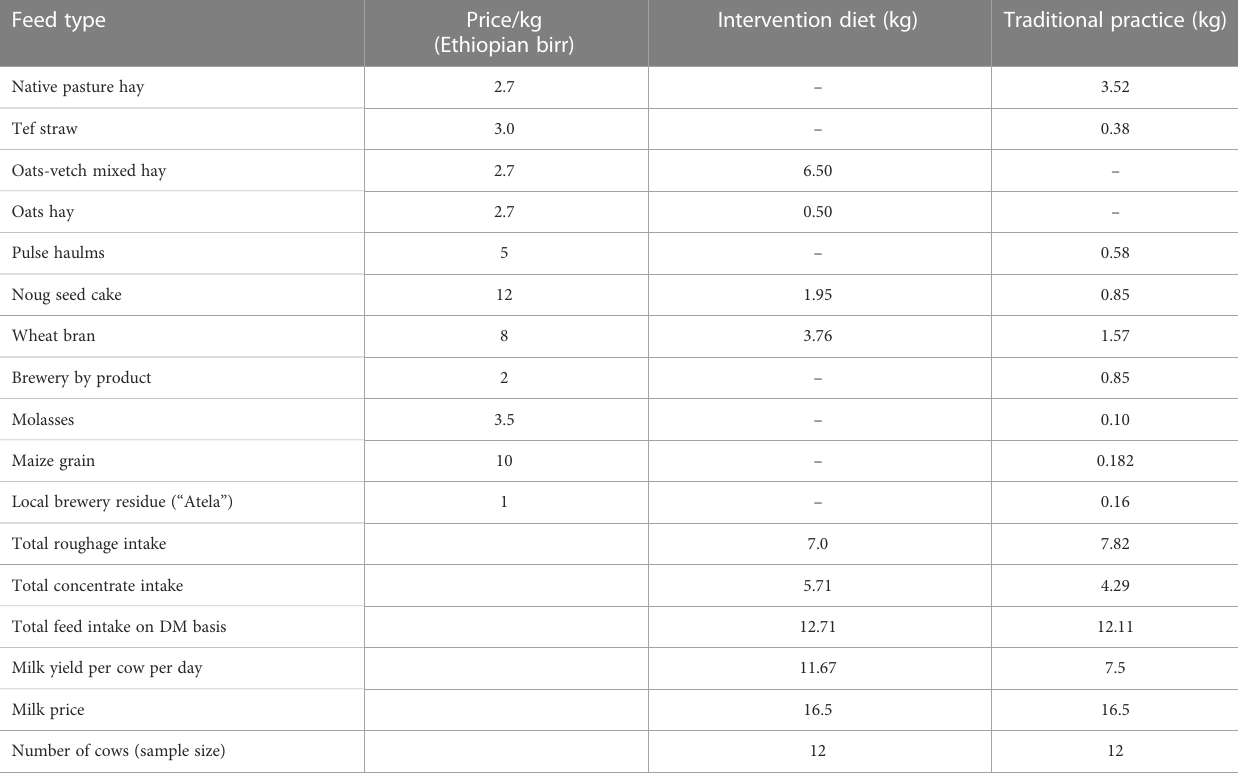
TABLE 1 Feed types and proportion of the diet used in the intervention and traditional feeding